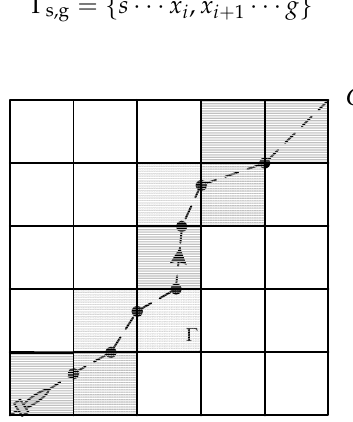
Figure 1. Example of a path, in which the dotted line represents path Γ s,g